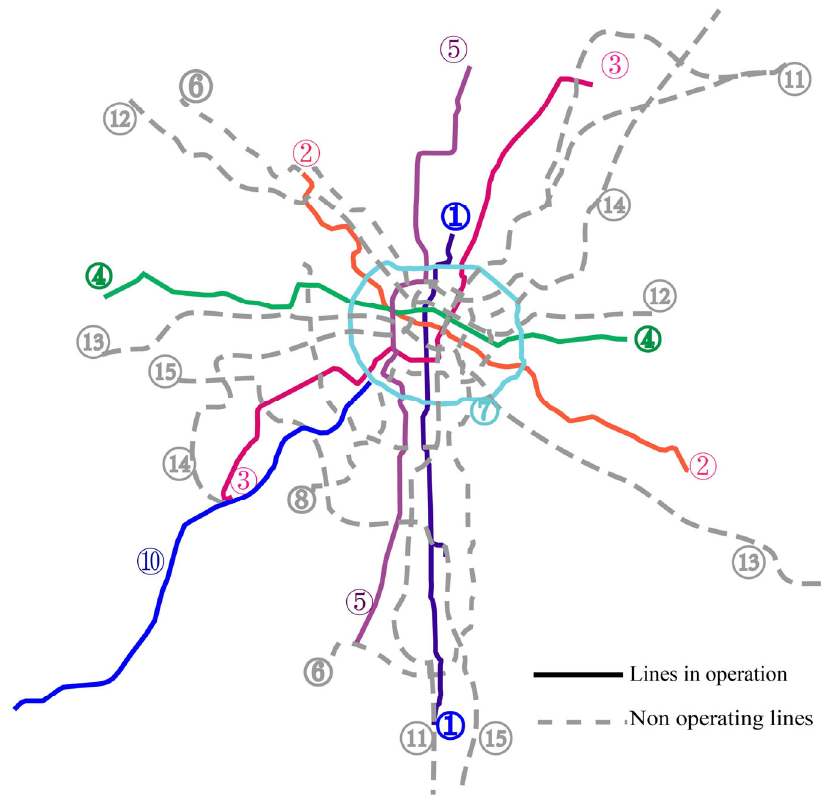
Figure 3. Chengdu rail transit network in planning. Table 4. Construction schedule of the seven metro lines used in this case study.